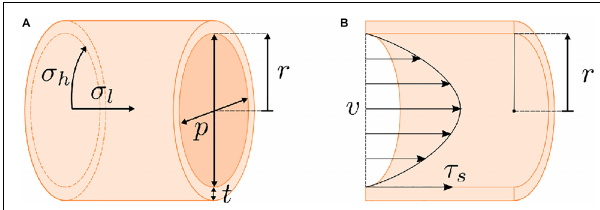
FIGURE 2 | Stresses present for dynamic flow of a fluid through a tube. (A) Pumping a liquid or gaseous medium through a tube will generate a pressure on the tube walls. The highest stress resultant from this pressurization is the hoop stress ( σ h ). Any scaffold must possess sufficient strength to compensate for this hoop stress. (B) Fluid movement will also result in a shear stress ( τ s ) on the walls of the tube. Generally, these factors ( σ h and τ s ) can be calculated based on the geometry of the tube, i.e., wall thickness (t) and inner radius (r), the pressure (p) on the tube walls, the flow rate of the fluid (v), and the viscosity of the fluid. However, these calculations are complicated by scaffold porosity and the potential for effects of cell growth on the scaffold over the course of an